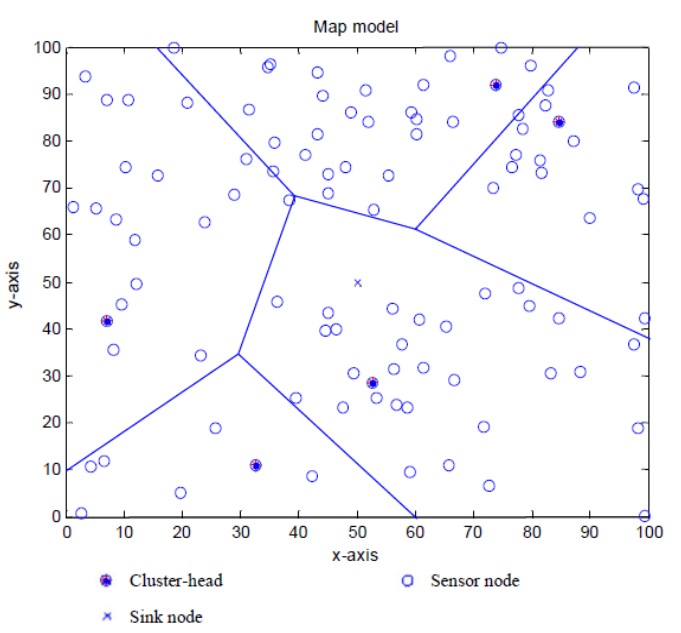
Figure 2. A non-uniform distributed